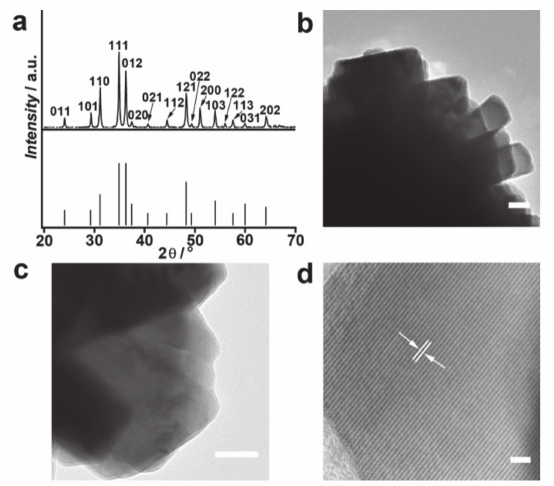
Figure 2. ( a ) Powder XRD pattern of as-prepared FeSe 2 nanocrystals through employing FeSt 2 as an iron precursor and OLA for solubilization of Se. The vertical lines on the bottom correspond to orthorhombic marcasite-type structures of FeSe 2 (PDF = 21-0432 and 74-0247). ( b , c ) TEM analysis of as-prepared FeSe 2 , the scale bar is 50 nm. ( d ) HRTEM analysis of as-prepared FeSe 2 resolved the reflection from the (110) plane, with a lattice spacing of 3.8 ± 0.2 Å, the scale bar is 2